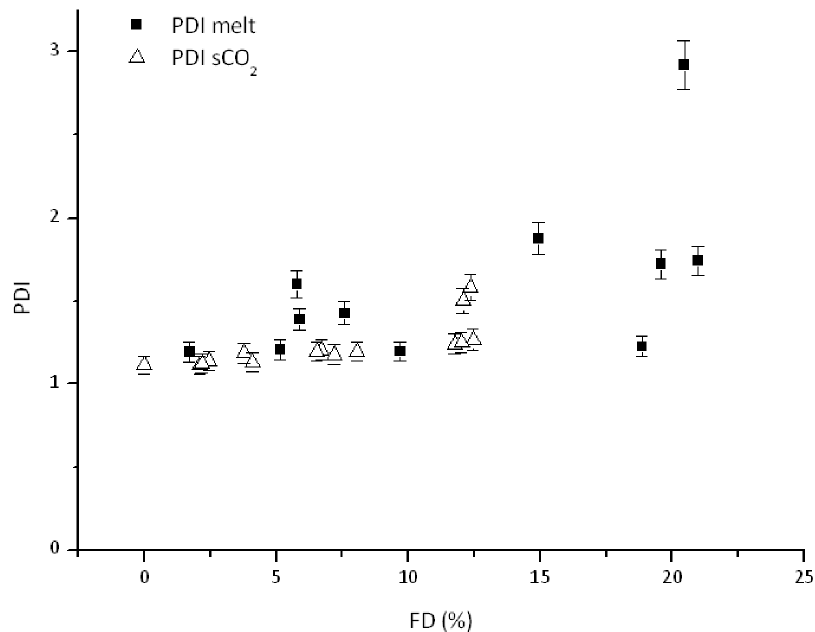
Figure 9. PDI comparison of reactive interfacial agents made in melt and scCO 2.